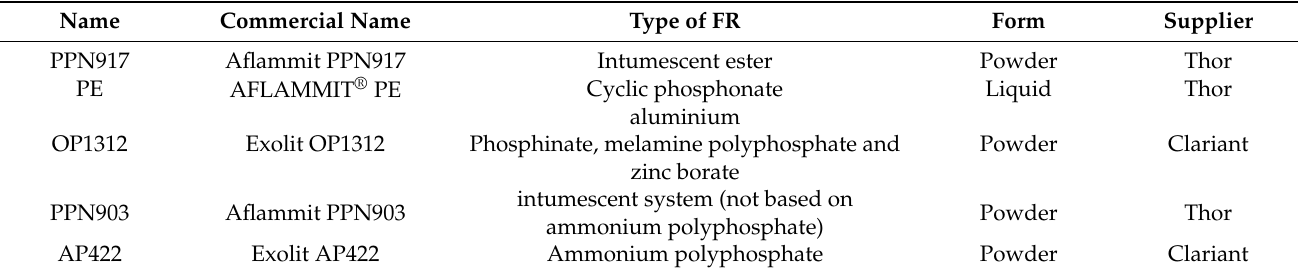
Table 1. Flame retardants applied on the core material.